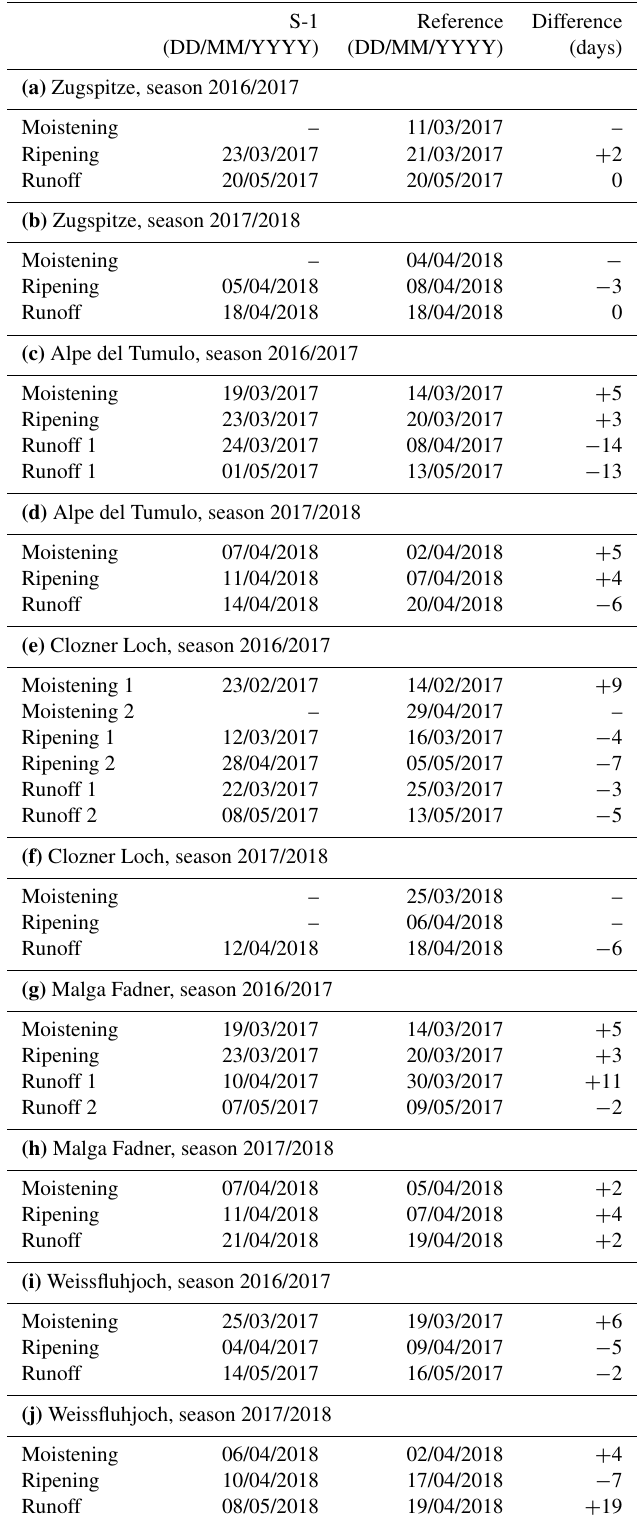
Table 5. Onset times for the melt phases identified in the five test sites using the LWC and SWE (reference) and Sentinel-1 with the method proposed in the previous